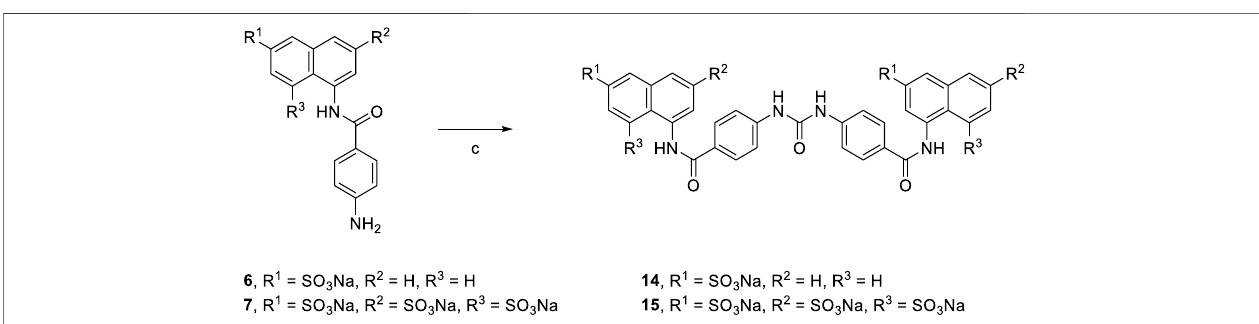
SCHEME 2 | Syntheses of suramin-like derivatives 14 and 15